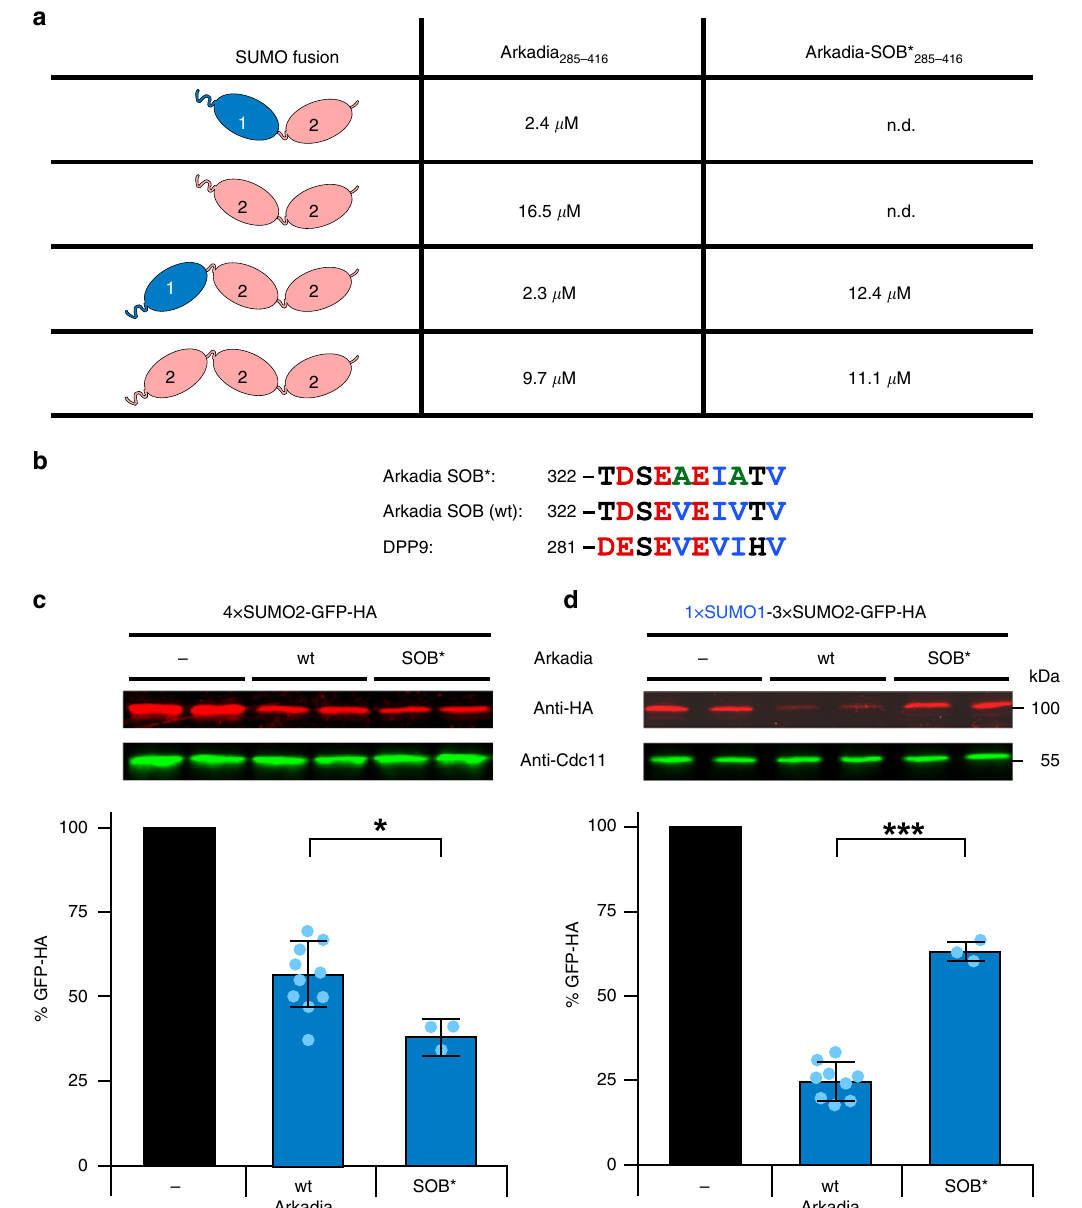
Fig. 2 A SUMO1-speci fi c binding site (SOB) in Arkadia mediates speci fi city. a Dissociation constants ( K D ) for the dimeric and trimeric SUMO chains listed derived from ITC measurements such as the ones shown in Supplementary Fig. 3. N.d., not determined. b Depiction of the wild-type SOB sequence and its mutant version (SOB*), in which two Val residues were mutated to Ala in an alignment with a similar motif in DPP9. c , d , Comparison of targeting ef fi ciencies of the same substrates as in Fig. 1c by wild-type and SOB* versions of Arkadia upon their co-expression in S. cerevisiae . The analysis was carried out as described in Fig. 1c. Bars represent the means. Standard deviations (SD) are indicated by error bars. Quanti fi cations are derived from experiments with nine independent transformants for wild-type Arkadia (same as in Fig. 1c) and three independent transformants for its SOB* mutant version. Asterisks indicate signi fi cant differences with p -values < 0.02 (one), p -values < 0.001 (three). Statistical signi fi cance was determined with unpaired and two-sided Student ’ s t -tests. Source data for a , c , and d are provided as a Source Data fi